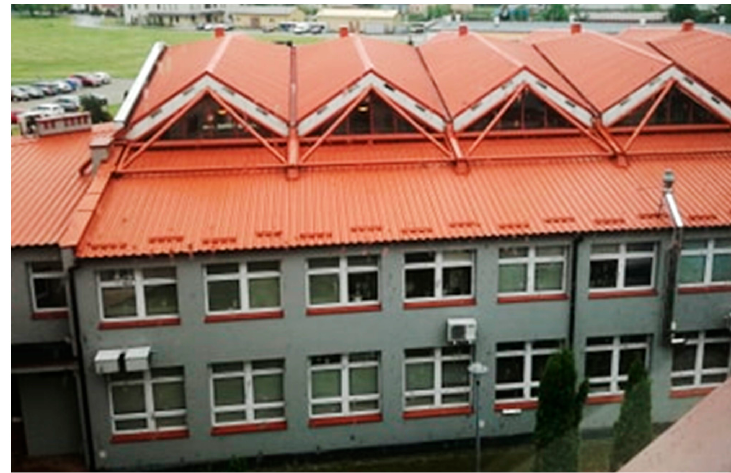
Figure 1. Transformed folded shell sheeting twisted with two skew directrices.